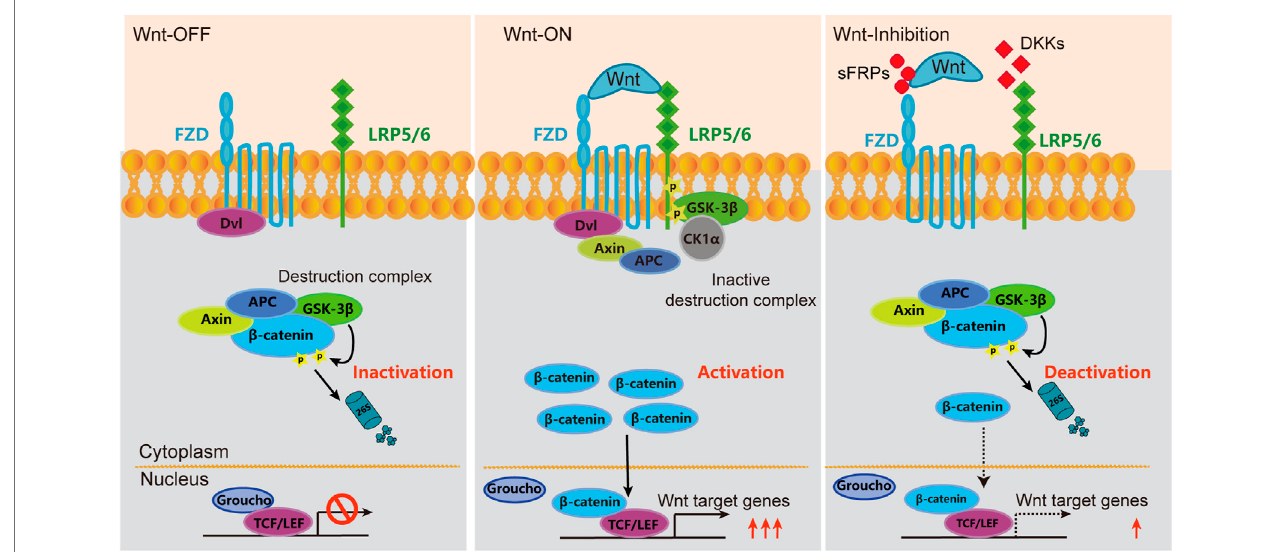
FIGURE 2 | Schematic diagram of Wnt/ β -catenin signaling pathway in inactivated, activated and deactivated states. In the quiescent Wnt/ β -catenin-dependent pathway (Wnt Off), β -catenin undergoes continuous ubiquitination in the absence of Wnt protein by the destruction complex. In this state, Wnt target genes are suppressed by Groucho and TCF/LEF transcription factors. Upon Wnt binding to FZD receptors and the co-receptor Lrp5/6 and formed a ligand-receptor complex called the “ signalosome, ” which further recruit the intracellular Dvl and components of the destruction complex to the cell membrane (Wnt On). This would prohibit theformationofdestructioncomplexandthuspreventsthedegradationof β -cateninandallowingitsnucleartranslocation. β -cateninwouldsubsequentlybindwithTCF/ LEF transcription factorstoinhibittheirDNAbinding.Wnttargetgenes,suchas Axin2 and Nkd1 ,aredisinhibitedtotranscript. Someextracellularmoleculescouldinhibit the formation of signalosome. For example, DKKs can competitively bind to LRP6, while sFRPs can directly bind to Wnt proteins and reduce the activity of signal